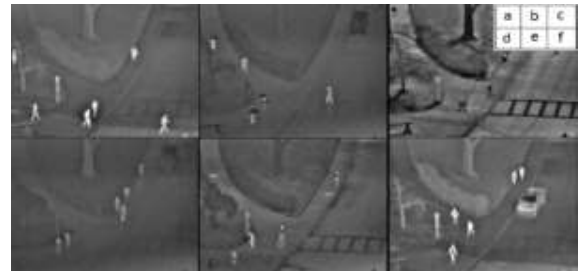
Figure 3. Samples of thermal images in different atmospheric situations